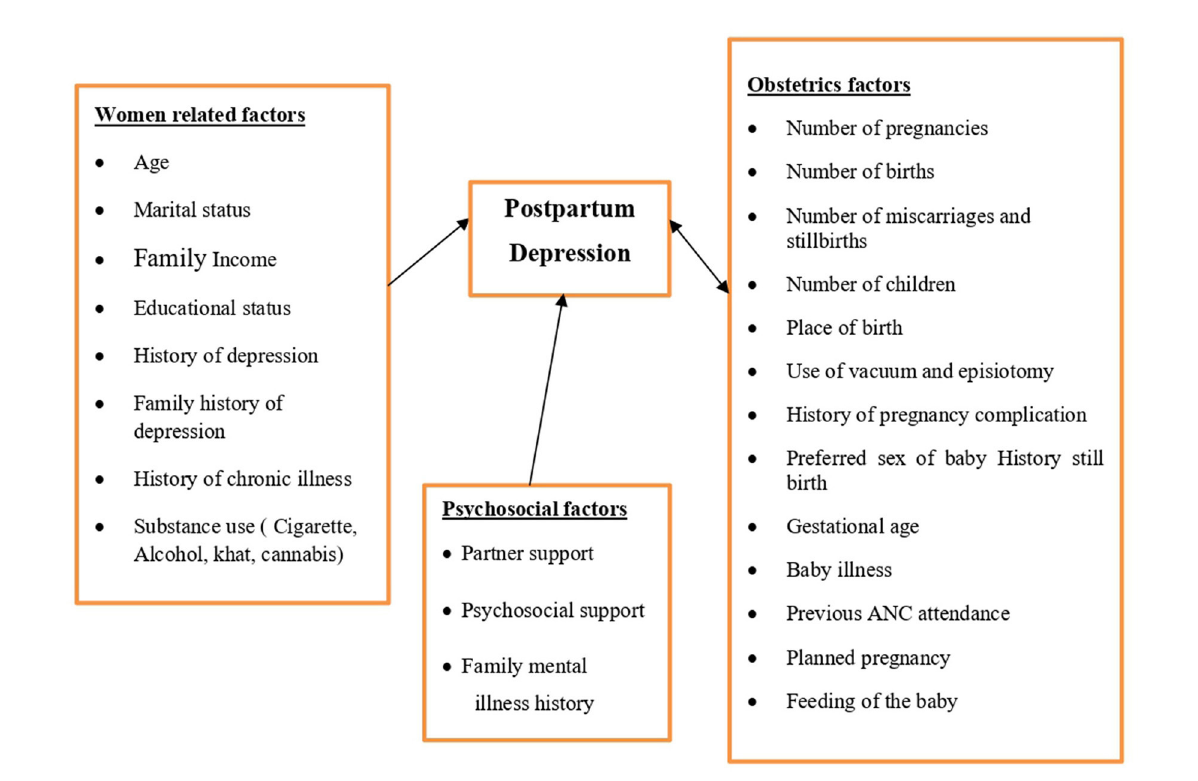
FIGURE1 Conceptual framework of postpartum depression and associated